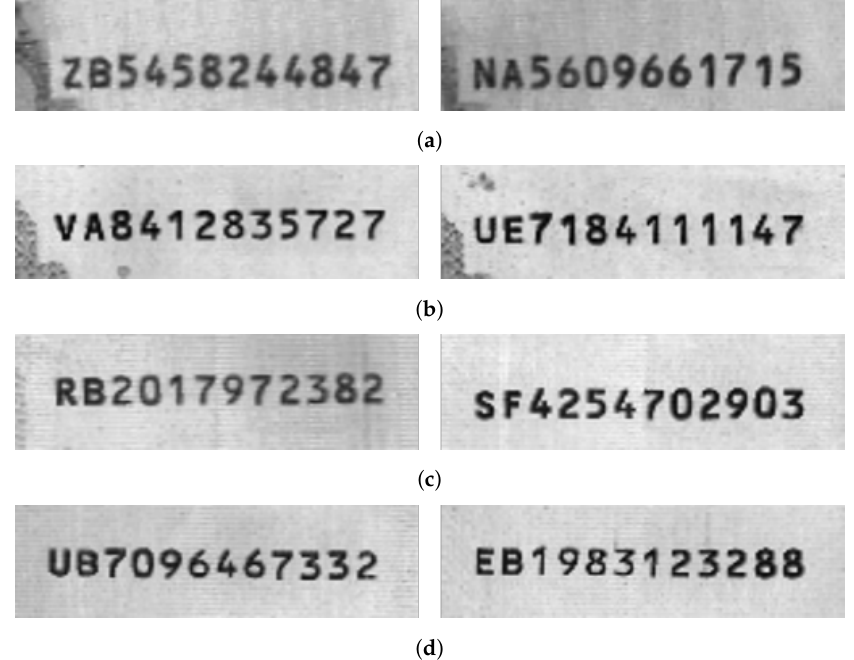
Figure 11. Typical images from set D. ( a ) 5 Euro ( b ) 10 Euro ( c ) 20 Euro ( d ) 50 Euro.